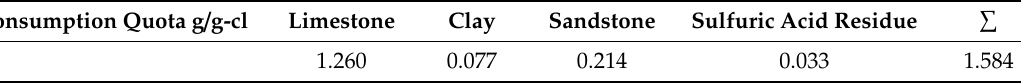
Table 9. Consumption quota of the wet raw